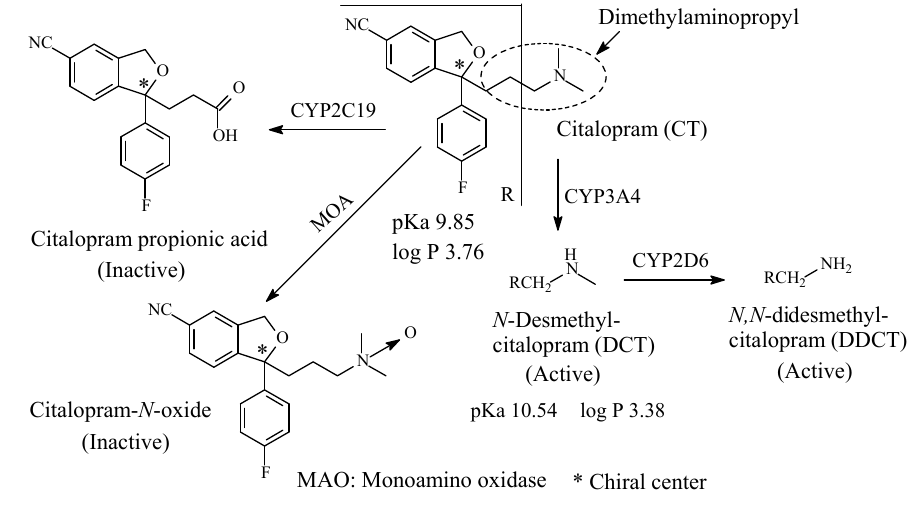
Figure 11. Metabolic pathways of citalopram.